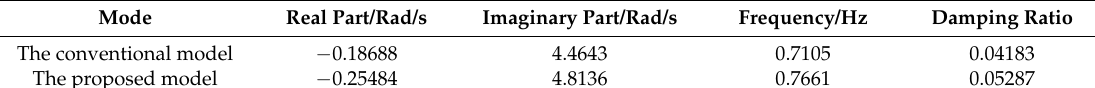
Table 3. Objective mode tuned by different models in the Eastern China power grid (ECPG).